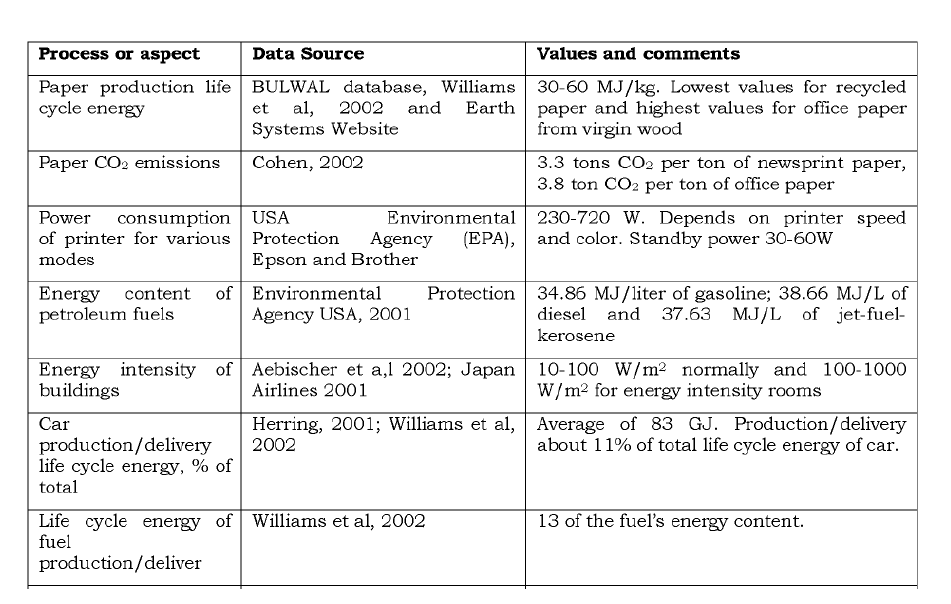
Data sets used for inventory analysis of the traditional and electronic